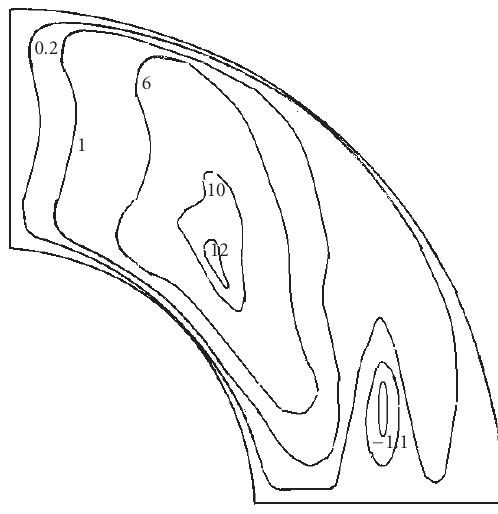
Figure 4.3. Level ψ curves multiplied by 10 4 for Re = 3000.